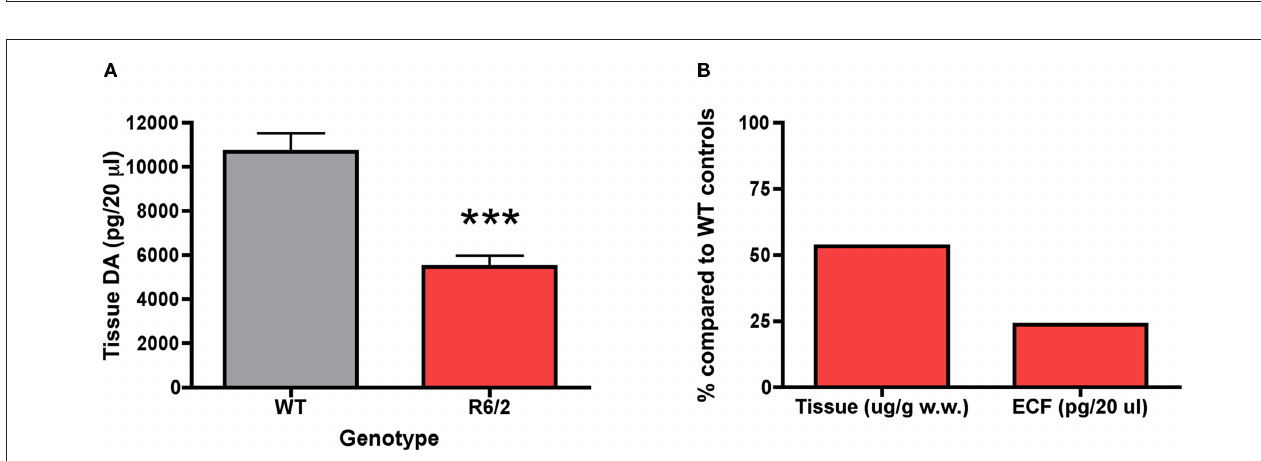
Figure 3 | In vivo microdialysis measurements of basal levels of extracellular (A) dopamine and (B) DOPAC in striatum of r6/2 transgenic mice (7 weeks, n = 6 WT, 6 r6/2; 9 weeks, n = 6 WT, 6 r6/2; 11 weeks, n = 8 WT, 8 r6/2). Data are picograms per 20 μl sample. All data are mean ± SEM. * Indicates significantly different from WT, p < 0.05; ** indicates p < 0.001; *** indicates p < 0.005; + , ++ R6/2 week 7 vs. weeks 9 and 11 ( p < 0.05, 0.01, respectively).